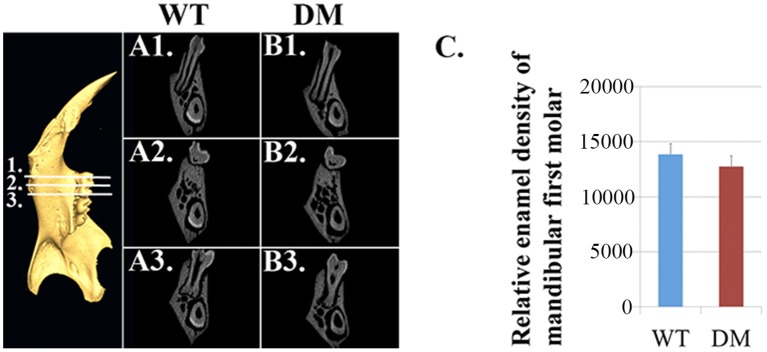
Quantification of enamel density in wild-type and double-mutant mandibular first molars. WT, Wild-type; DM, Double-mutant. (A1–A3) Cross-sectional views of wild-type hemi-mandible at reference planes 1, 2 and 3. (B1–B3) Cross-sectional views of double-mutant hemi-mandible at reference planes 1, 2, and 3. (C) We averaged the measurements obtained from mesial, middle and distal cusps (reference planes 1, 2, and 3). The double-mutant molars demonstrated lower enamel density than wild-type molars, but the difference was not statistically significant (P = 0.35).